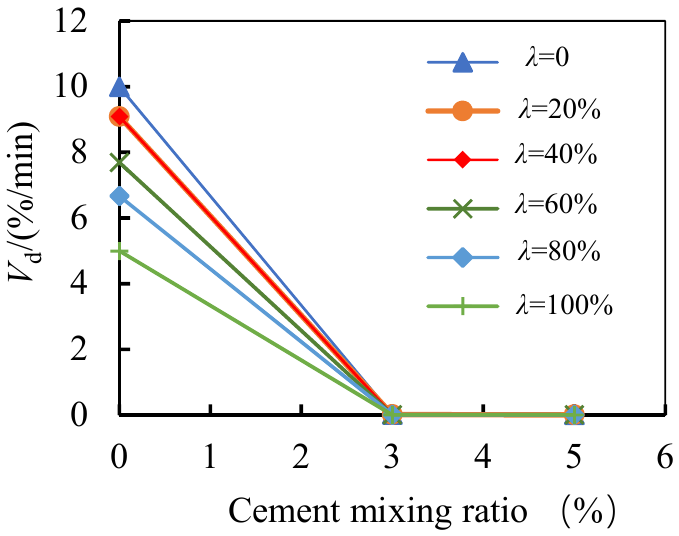
Figure 11. Disintegration rate vs cement mixing ratio with different blending ratios. It can be seen from Figure 11 that the disintegration rate of the mixed soil with cement mixing ratios of 3% and 5% is far less than that of the blended soil without cement. Taking a blending ratio of 40% red clay as an example, the disintegration rate of cement mixing ratio of 0, 3%, and 5% are 9.09%/min, 0.0142%/min, and 0.00941%/min, respectively. The disintegration rates with 3% and 5% cement are about 0.156% and 0.104% of those without